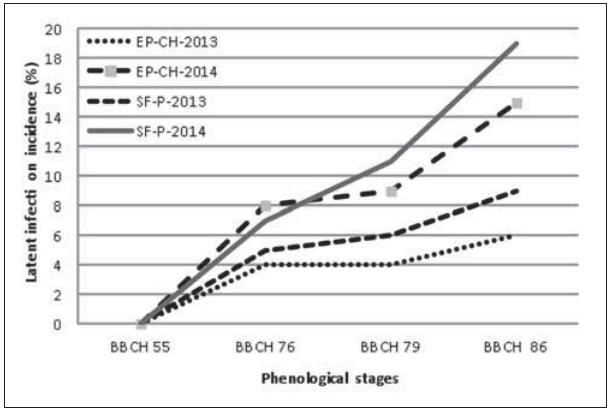
Figure 1 Percentage of latent infection caused by Monilinia spp. in tow